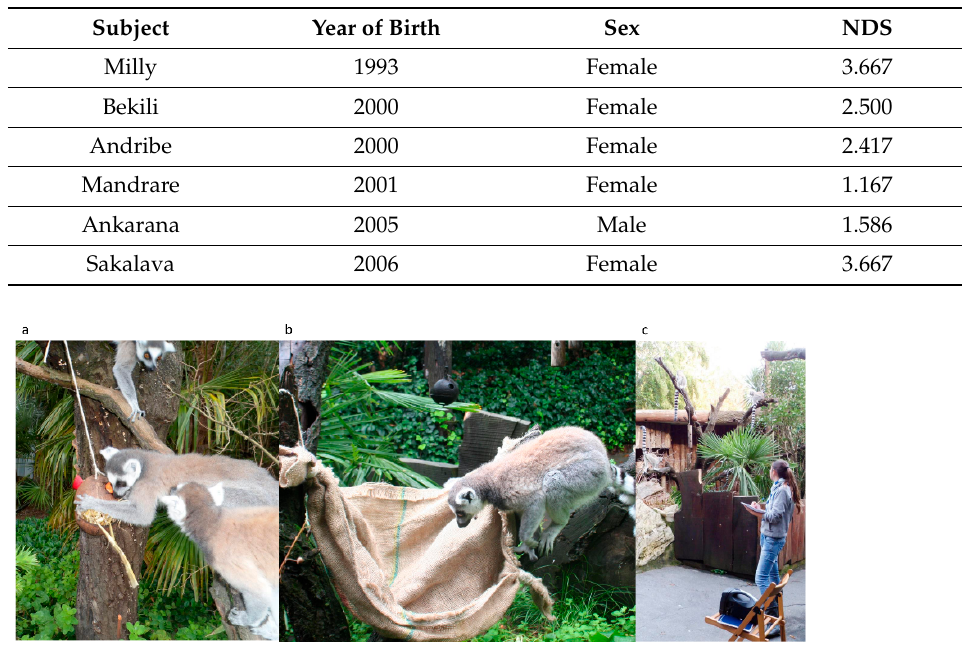
Figure 1. Enrichment types provided to the study group of ring-tailed lemurs: ( a ) food-based en ‐ richment, E1; ( b ) physical enrichment, E2; ( c ) auditory enrichment, E3.